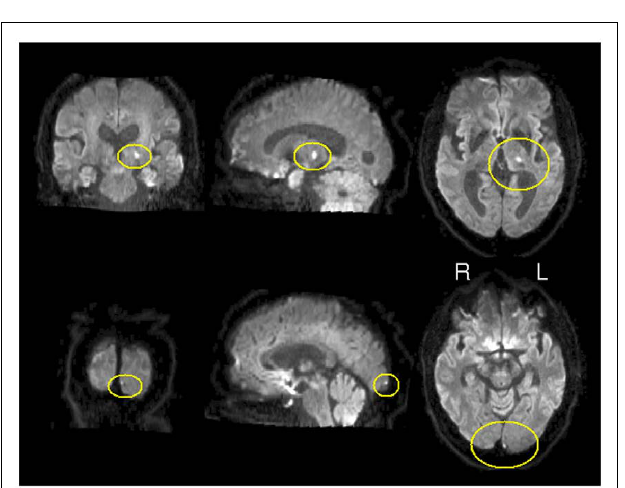
FIGURE 3 | Intra-subject CCM eyes-open and eyes-closed. The concordance of eyes-open and eyes-closed scans was assessed within each subject separately yielding an individual CCM per subject.These CCMs were then averaged. Note that early visual cortex (V1) shows relatively low concordance compared to other brain regions. Crosshair is positioned in the Calcarine sulcus.